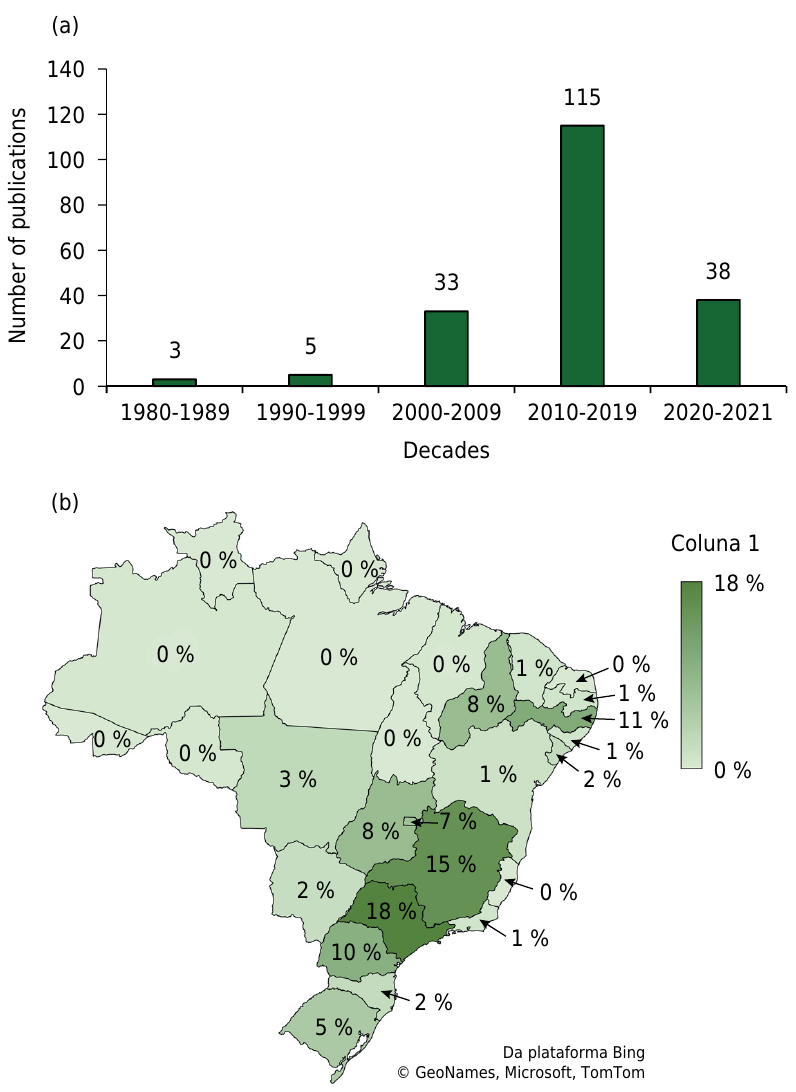
Figure 4. Current status of publications on soil enzymes in Brazil. Distribution of publications per decade (a); distribution of publications per Brazilian state